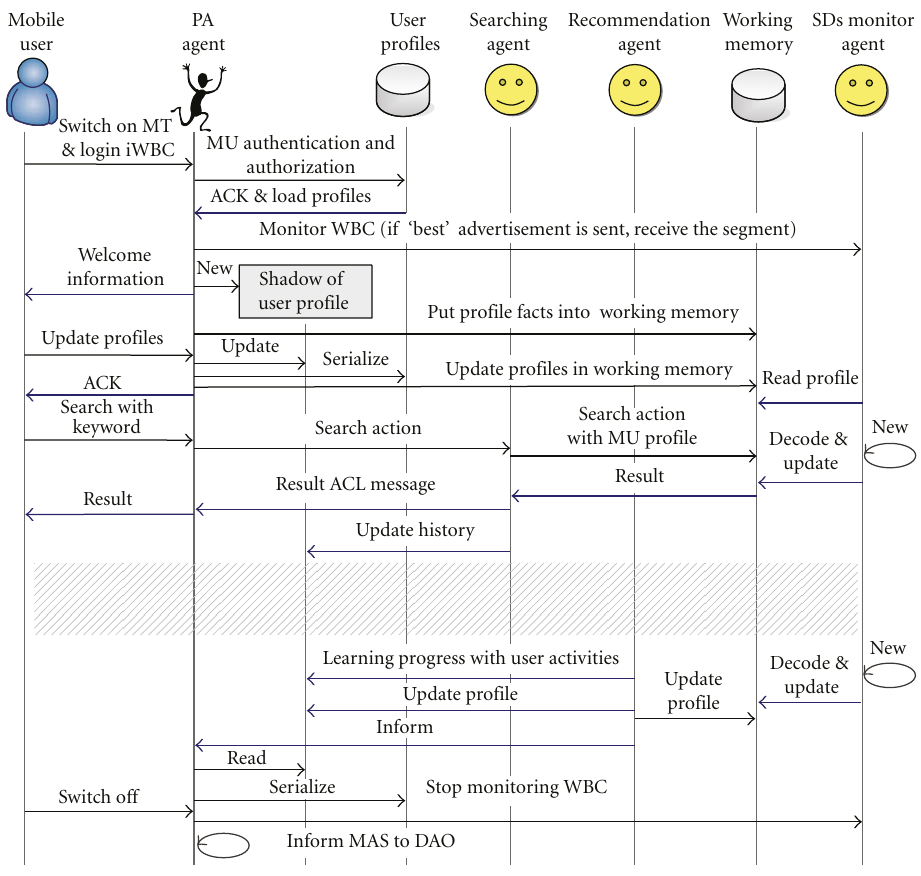
Figure 5: The time sequence diagram of the interaction between agents, profiles, and working memory.